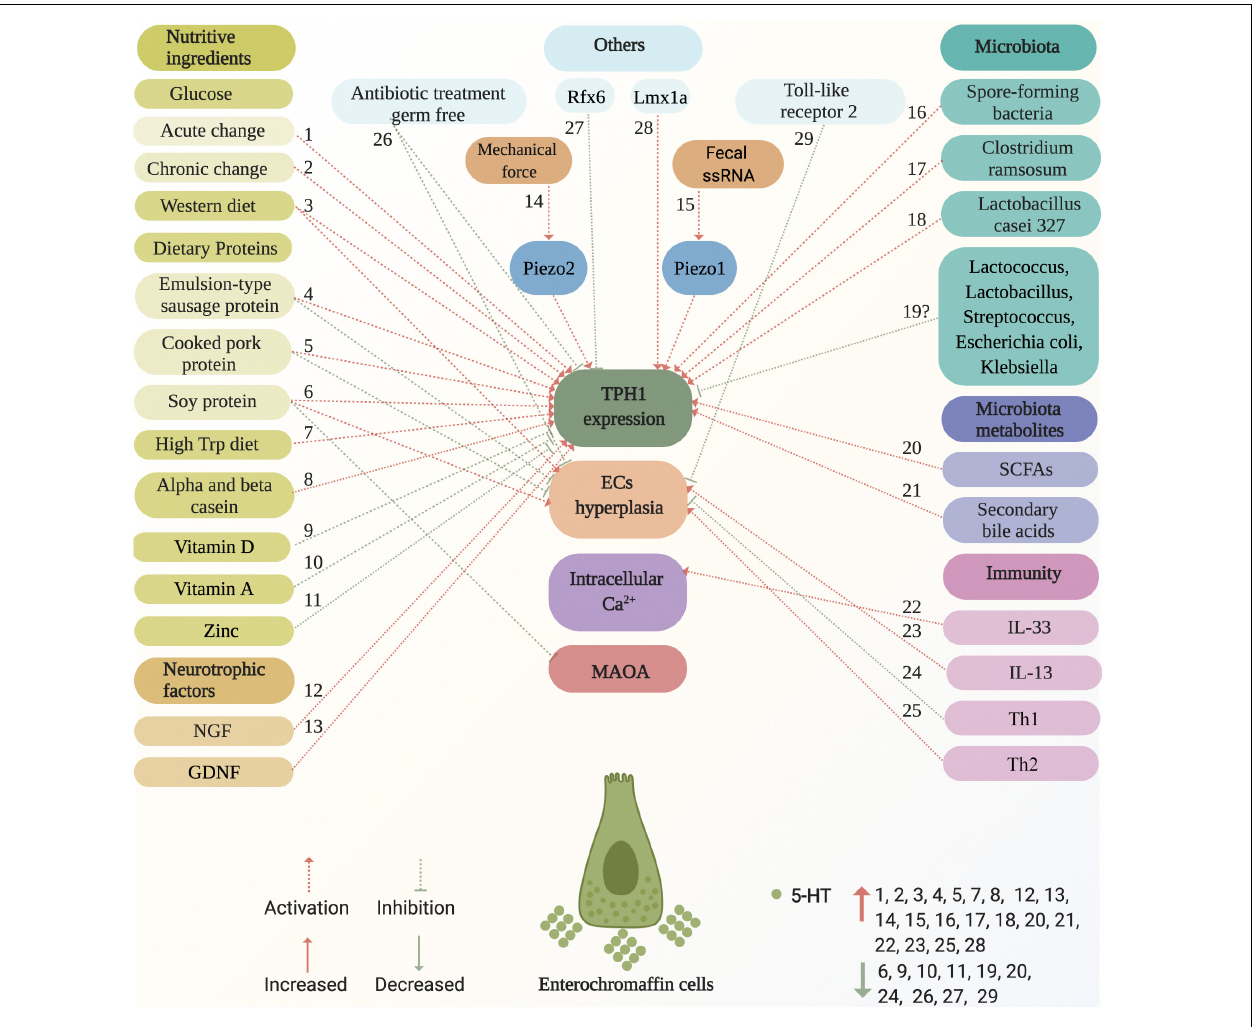
FIGURE 4 | Factors and potential mechanisms of regulating enterochromaffin cells synthesis of 5-HT. Various factors activate or inhibit ECs synthesis of 5-HT, including nutritive ingredients (glucose, dietary proteins, western diet, high Trp diet, casein, vitamin D, vitamin A, and zinc), neurotrophic factors (NGF and GDNF), microbiota (spore-forming bacteria and Clostridium ramosum ), metabolites (SCFAs, such as acetate, propionate, butyrate, and secondary bile acids), immunity (IL-33, IL-13, TH1, and TH2), mechanical force, fecal ssRNA, as well as others (germ-free, Rfx6, Lmx1a, and antibiotic treatment). These are marked with red and green dotted arrows for activation and inhibition, respectively. The potential mechanisms of factors that act on ECs are involved in the effects on TPH1 expression, ECs hyperplasia, intracellular Ca 2 + , and MAOA. Factors that increase and decrease 5-HT levels are marked with red up and green down arrows, respectively. ECs, enterochromaffin cells; NGF, neuron growth factor; GDNF, glial cell-derived neurotrophic factor; ssRNA, single-stranded RNA; TPH1, tryptophan hydroxylase 1; MAOA, monoamine oxidase A; SCFAs, short chain fatty acids; Trp, tryptophan; Th, T helper.